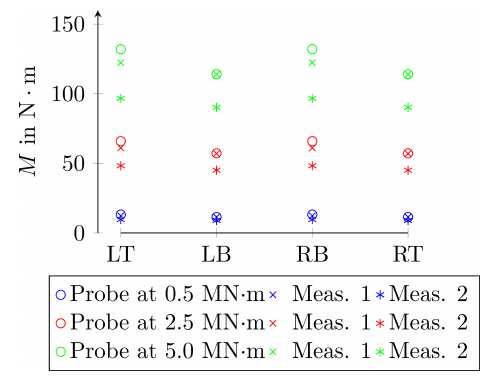
Figure 11. FE validation for the TM measurement.